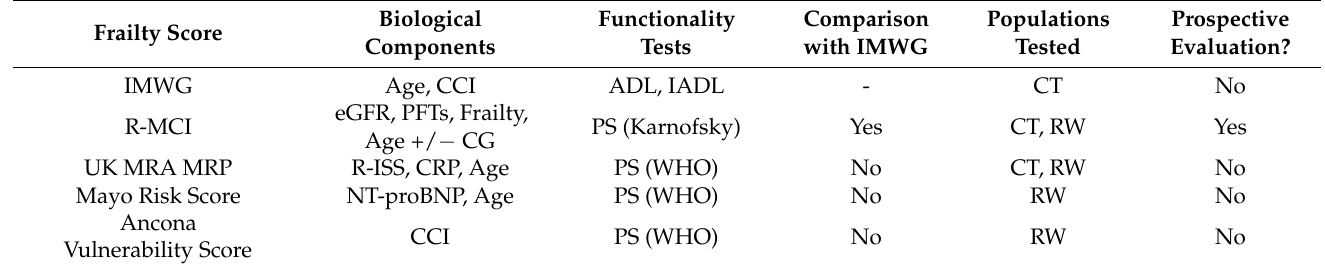
Table 1. A comparison of the main Myeloma-specific frailty scores; Table from Cook G, et al. Leukemia . (2020)